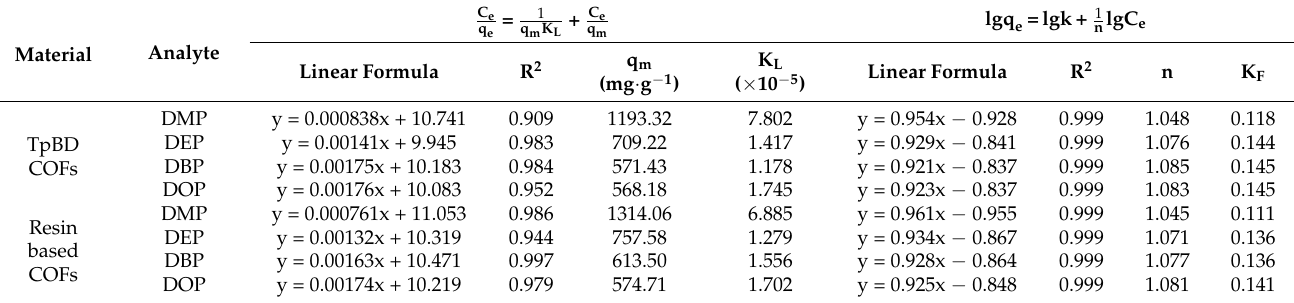
Table 2. Static parameters of